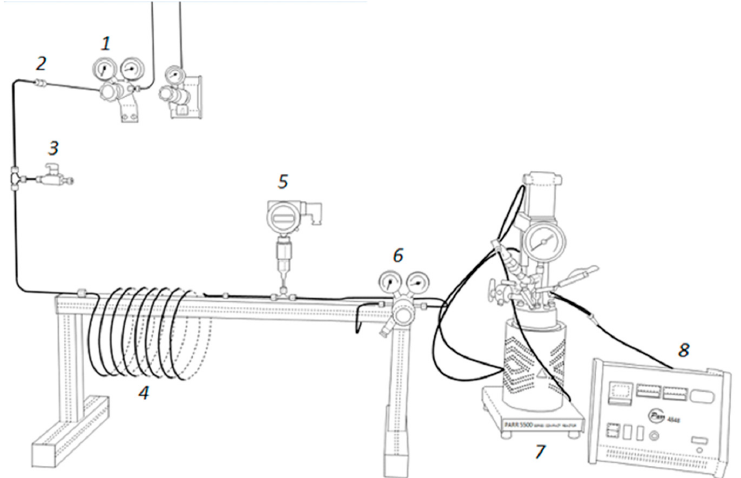
Figure 6. Hydrogenation installation: 1 and 6-pressure reduction valves, 2-stopcock, 3-side valve, 4-hydrogen reservoir, 5-manometer with display, 7-autoclave Parr 5500, 8-pressure, temperature, and stirring speed controller.